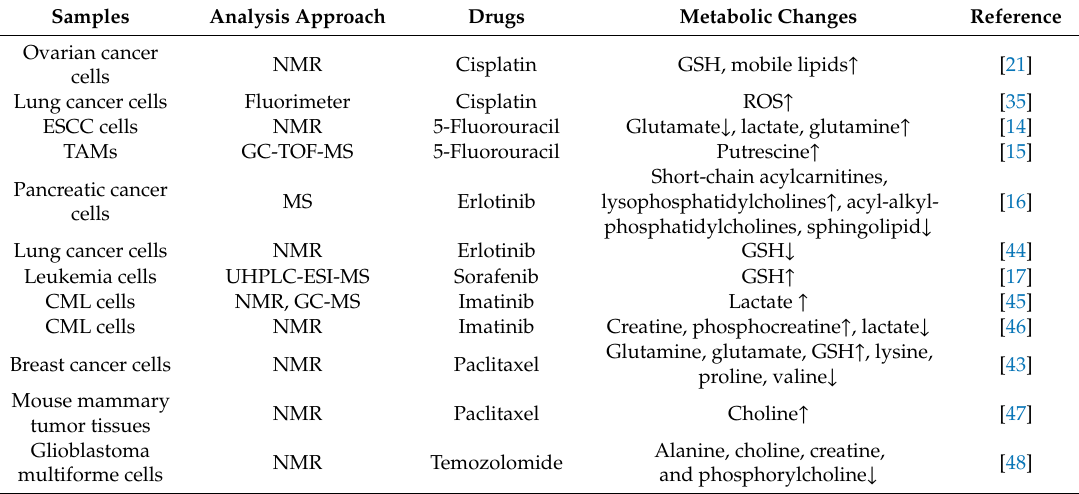
Table 1. Main metabolic changes of chemoresistant tumor